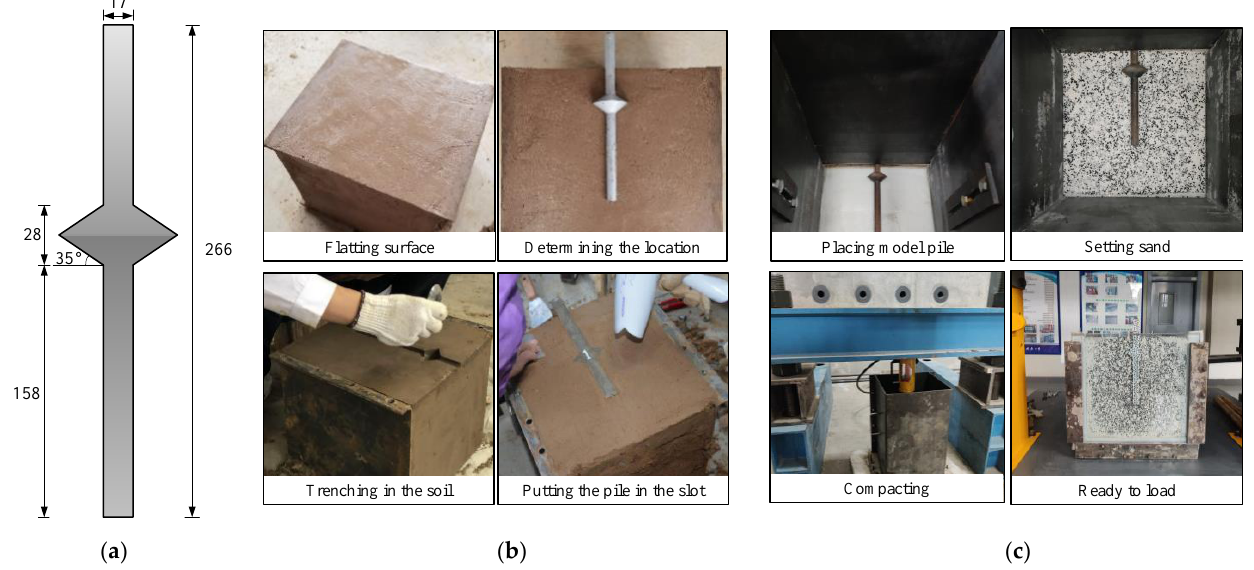
Figure 4. Model pile and the pile anchoring process: ( a ) schematic diagram of model pile; ( b ) photos of the embedding process of the pile in the undisturbed soil; ( c ) photos of embedding process of the pile in the sand.